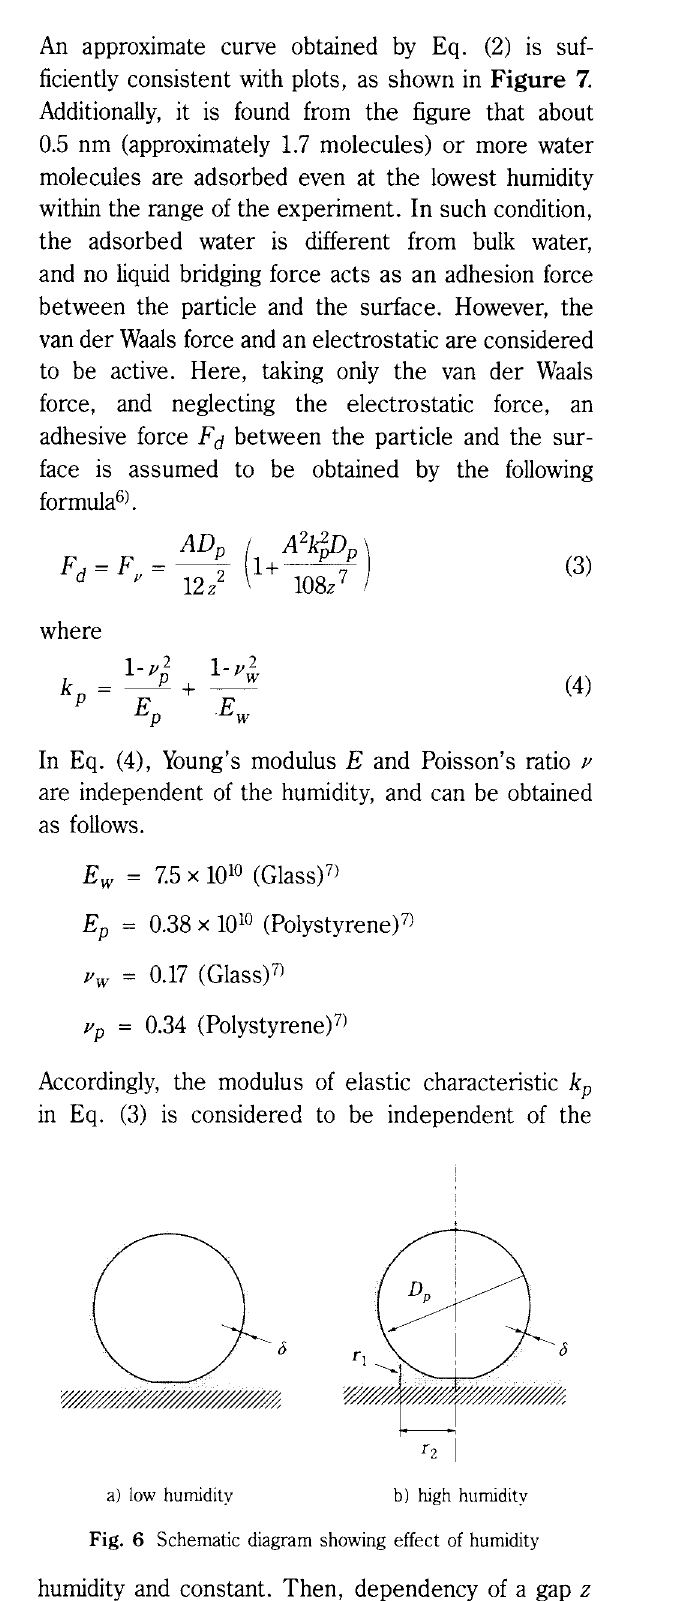
Fig. 6 Schematic diagram showing effect of humidity humidity and constant. Then, dependency of a gap z between a particle and a solid surface and Hamaker's constant A on the humidity is